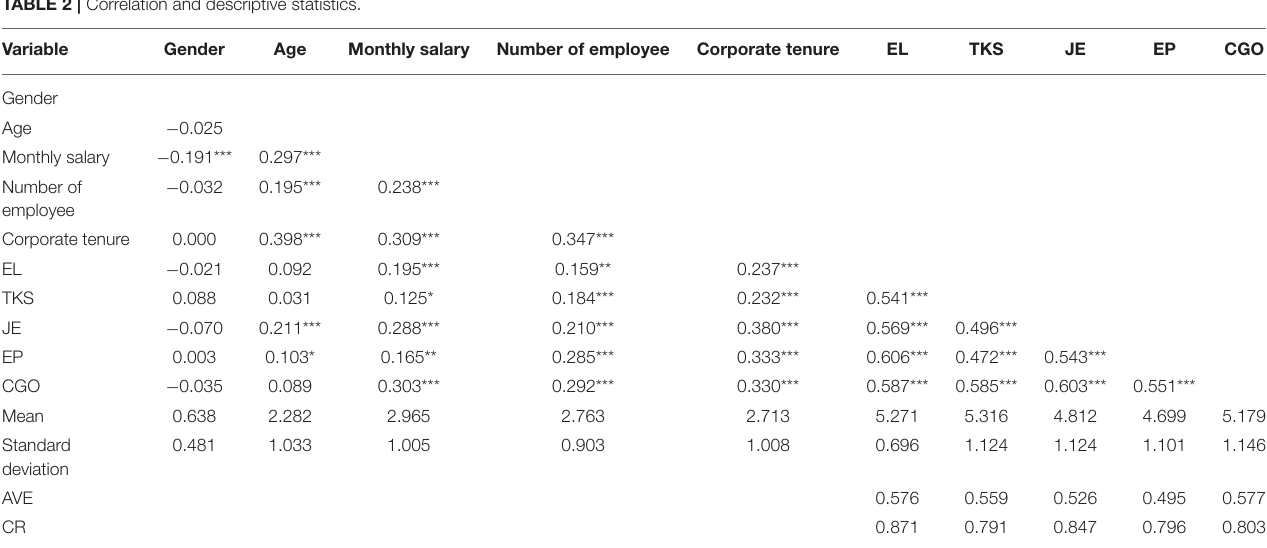
TABLE 2 | Correlation and descriptive statistics.